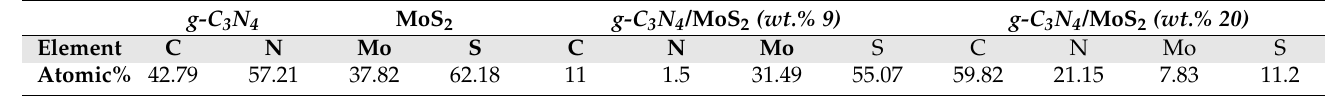
Figure 10. ( a ) SEM image; ( b ) live map; ( c ) element overlay; ( d ) elemental analysis; element ( e ) mo- lybdenum, Mo; ( f ) sulfur, S; ( g ) carbon, C and ( h ) nitrogen, N of the g-C 3 N 4/ MoS 2 composite. EDX elemental analysis results for graphitic carbon nitride, molybdenum disulfide and their composites are summarized in Table 4. Table 4. Elemental composition of synthesized materials from EDX elemental analysis. Table 4. Elemental composition of synthesized materials from EDX elemental